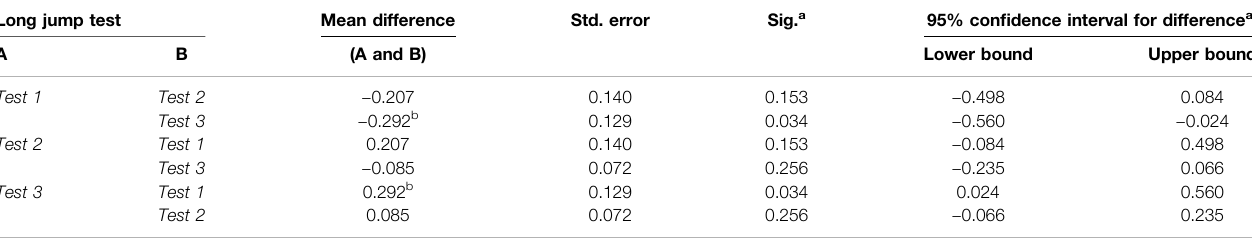
TABLE 4 | The signi fi cant difference among the tests of long jump distance performance. Long jump